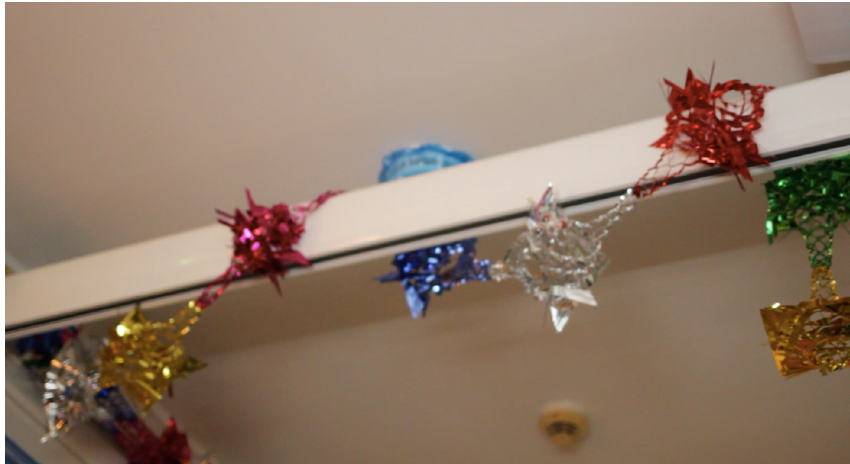
Figure 14. Decorations covering the hoist on the ceiling. April 2017.